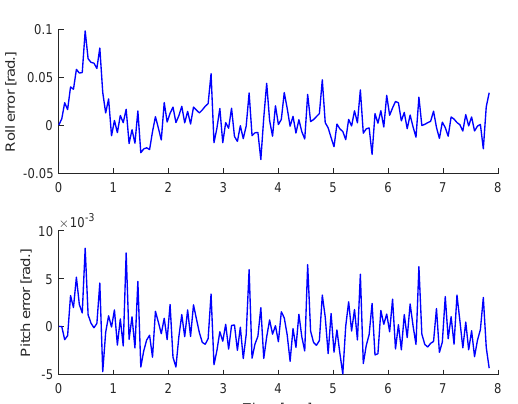
Figure 6: The initial errors were large due to the initial con- ditions, and the peak of the pitch value is due to a lower weight on its measurements while also be- ing prone to a wrong initial estimate of the angu- lar velocity. The error offsets in the noiseless case converged to zero.